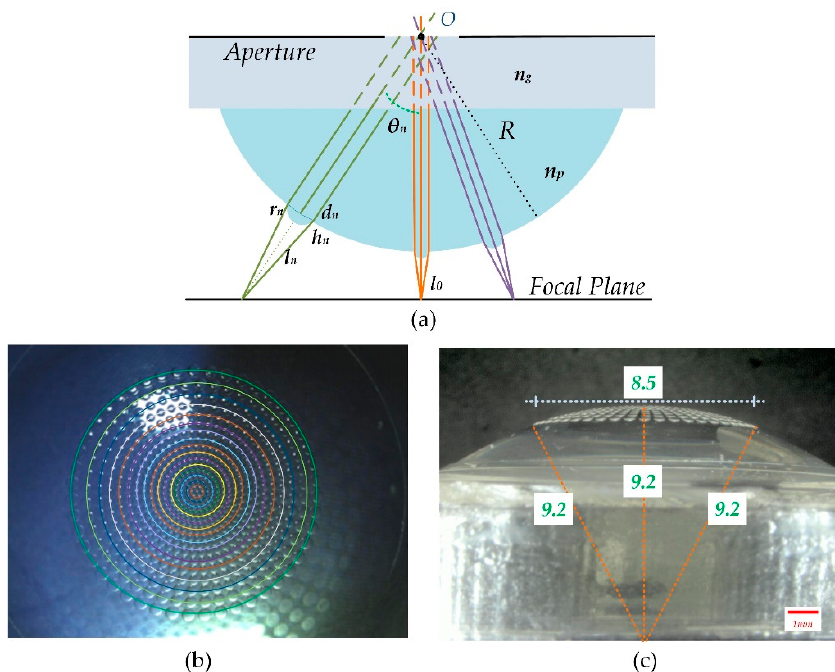
Figure 1. ( a ) Design of microlenses with multiple focal lengths on a curved surface; ( b ) image of curved compound eyes captured by optical stereoscopic microscope; ( c ) lateral view of curved compound eyes captured by digital microscope with large depth of field.